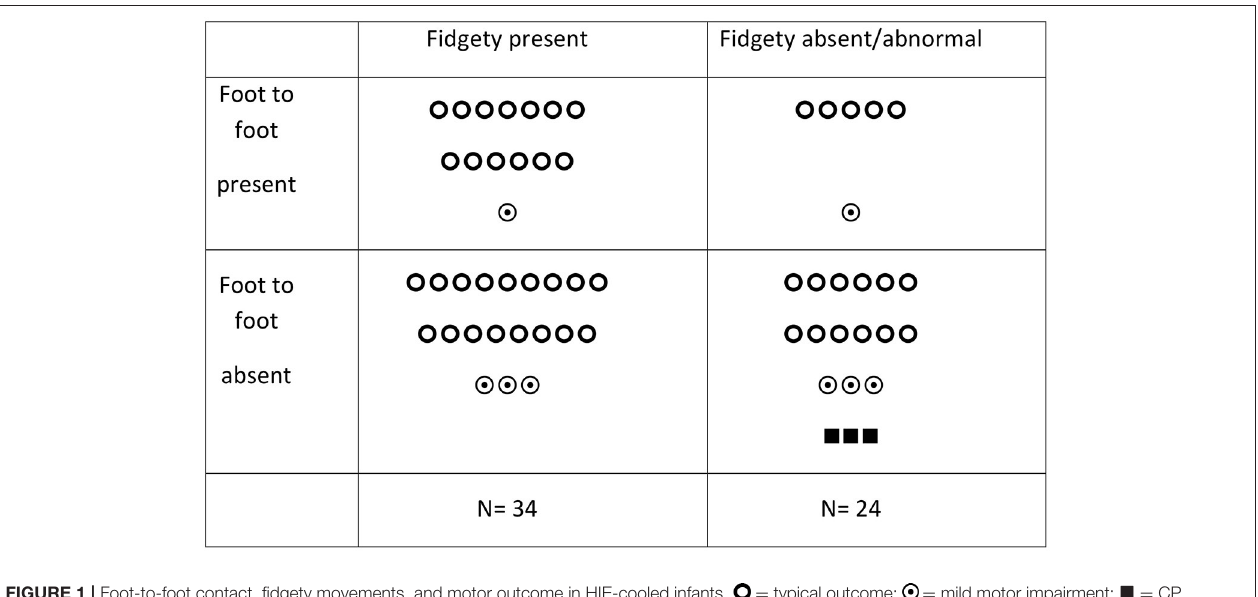
FIGURE 1 | Foot-to-foot contact, fidgety movements, and motor outcome in HIE-cooled infants. = typical outcome; = mild motor impairment; (cid:4) = CP.